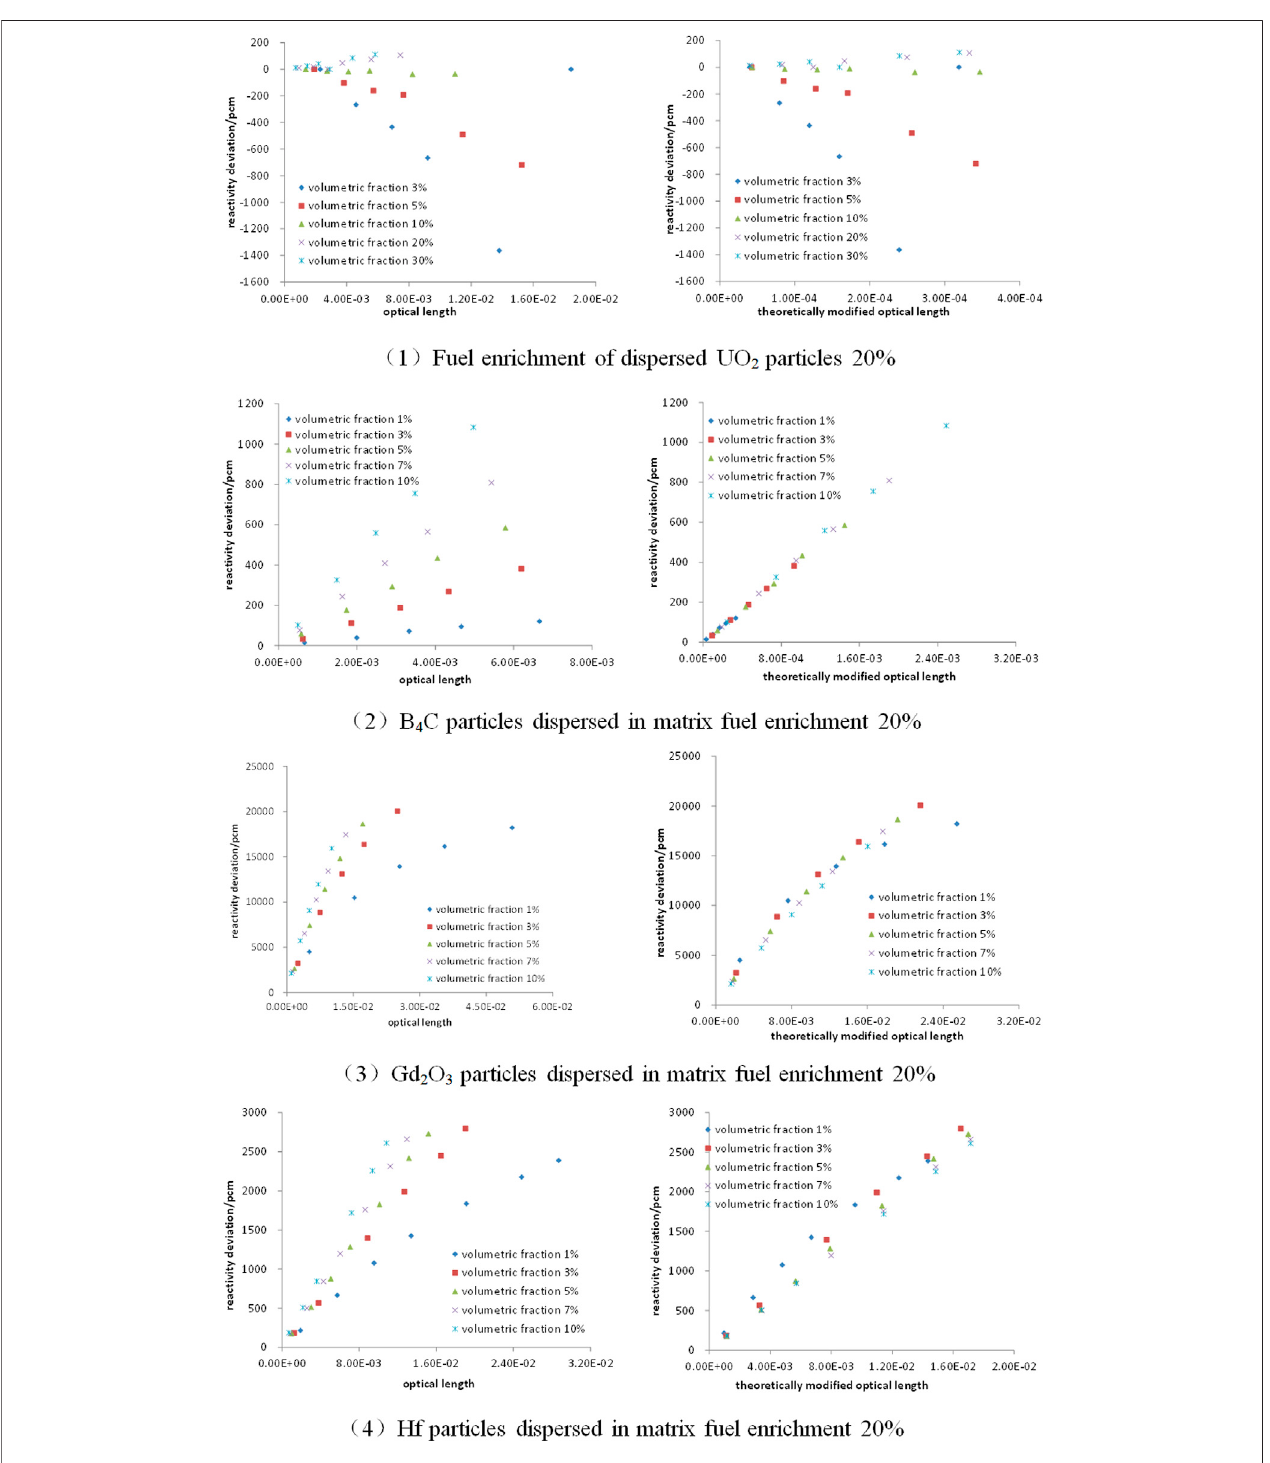
FIGURE 5 | Relationship between reactivity deviation and optical length or theoretically modi fi ed optical length under different volumetric fraction of particles.